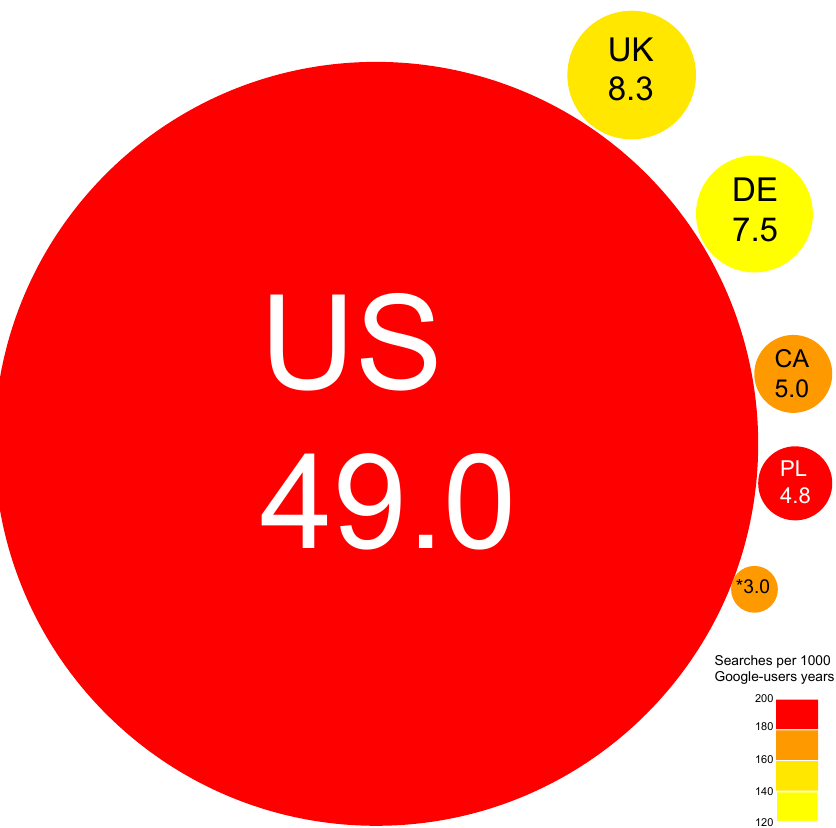
Figure 1. The number of heartburn-related queries per year in millions and the number of queries per 1000 Google-user years in each country. AU—Australia, CA—Canada, DE—Germany, PL—Poland, UK—the United Kingdom, US—the United States; rounds sizes are proportional to the number of heartburn-related queries per year. The color corresponds to the number of queries per 1000 Google-users years (darker color—higher